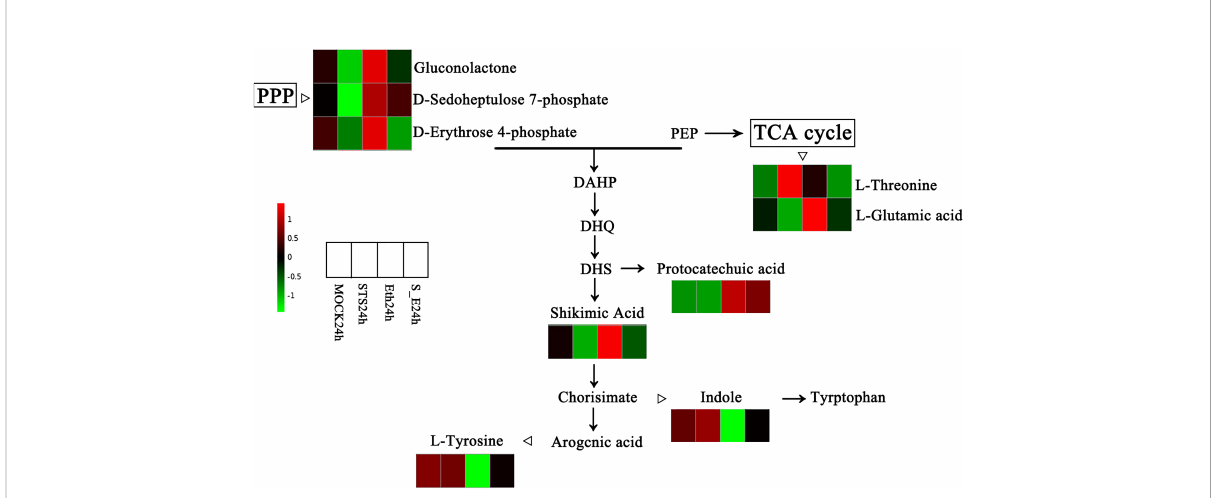
FIGURE 7 Changes of DAMs in the pentose phosphate pathway and amino acid biosynthesis. PPP, Pentose phosphate pathway; PEP, phosphoenolpyruvate; DAHP, 3-deoxy- a -arabinoheptulosonate-7-phosphate; DHQ, 3-dehydroquinate; DHS,